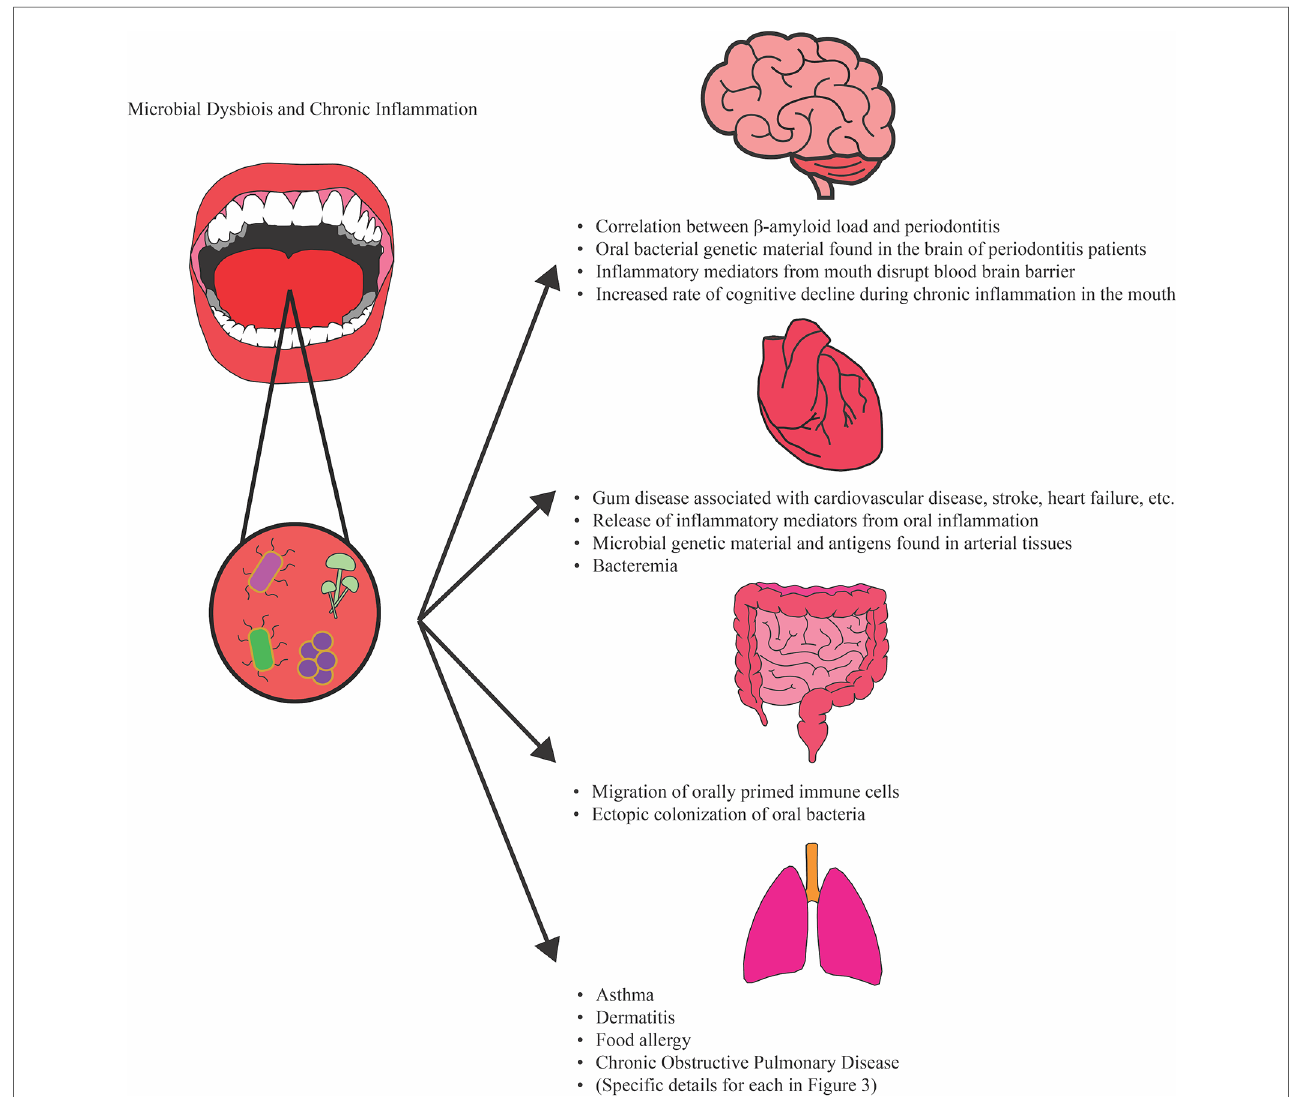
FIGURE 2 Associations between oral dysbiosis/chronic in fl ammation and pathologies in distant organs. Oral dysbiosis and chronic in fl ammation is associated with in fl ammatory conditions in distant organs, such as the brain, heart, intestines, and lungs. Associations between oral microbiota composition and allergy, dermatitis, asthma, and COPD development have also been reported and are covered in more detail in Figure 3 . In the brain, the presence of in fl ammatory mediators and bacterial antigens may increase the risk of Alzheimer ’ s disease progression and severity. Ectopic colonization and migration of orally primed immune cells have been found to exacerbate colitis in mice. Microbial genetic material and antigens have been found in arterial tissue, and chronic periodontitis have been associated with increased risk of cardiovascular